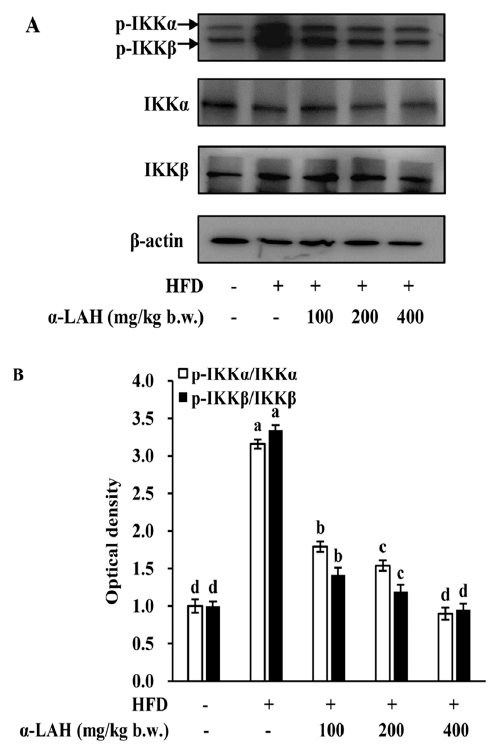
Figure 6. Effect of bovine α -lactalbumin hydrolysates ( α -LAH) supplementation on the activation of inhibitor of kappaB kinase (IKK) signaling pathway in epididymal adipose tissues of mice fed with high-fat diet. ( A ) A representative image of western blot analysis for p-IKK α / β in epididymal adipose tissues; ( B ) fold change in relative densitometric levels of p-IKK α /IKK α and p-IKK β /IKK β relative to the ND group. All data were presented as means ± standard deviations (SD) ( n = 6). Significance was determined by one-way analysis of variance (ANOVA) with the Duncan’s multiple-comparison test, and mean values without common letters indicate differences at p < 0.05.